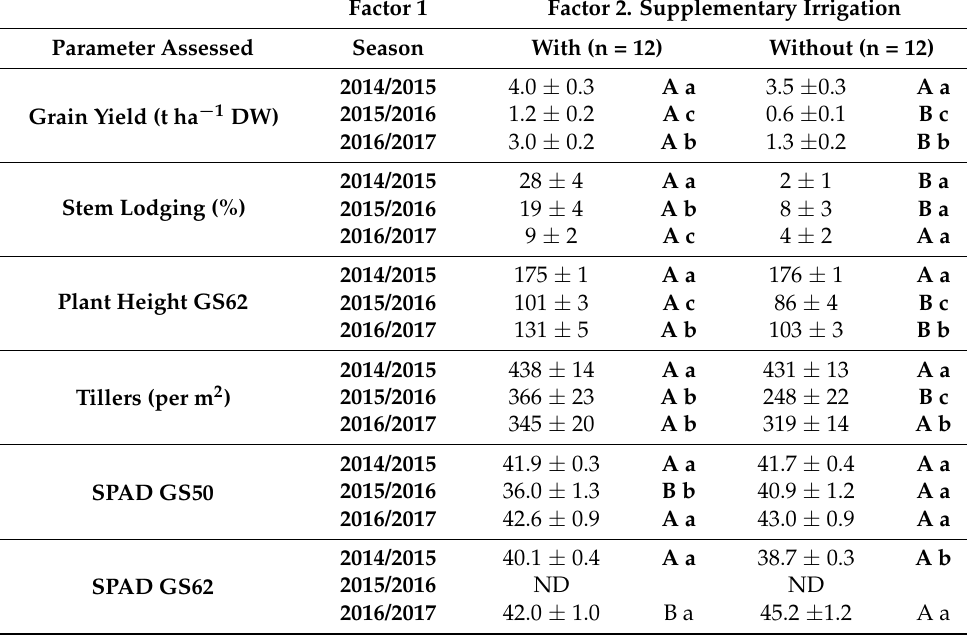
Table 2. Interaction means ± SE for the effects of growing season (2014/2015, 2015/2016 and 2016/2017) and supplementary irrigation (with or without) on spelt wheat (variety Rubiota) grain yield and yield-related growth